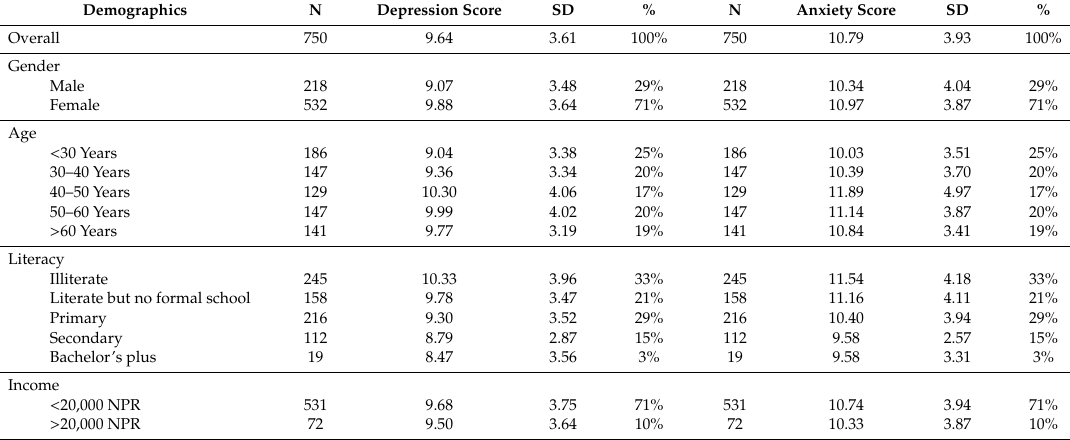
Table 2. Depression and anxiety symptom score.